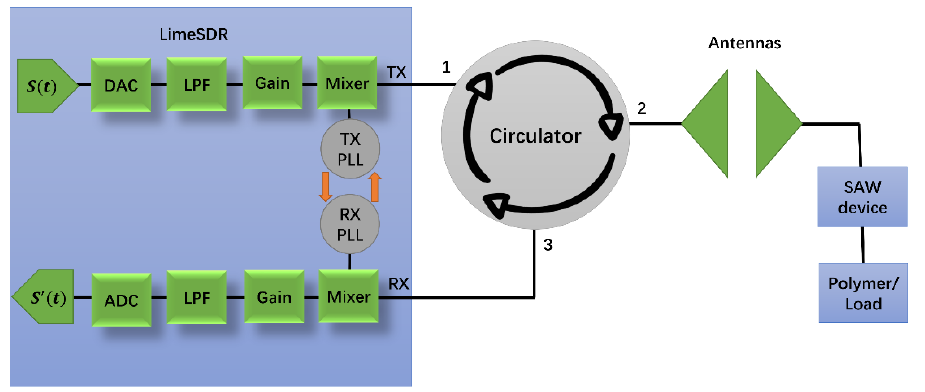
Figure 1. Proposed wireless sensing system including the LimeSDR-mini, circulator, two antennas, SAW device, and polymer (variable resistive load). On the circulator, the numbers 1, 2, and 3 mean port 1, port 2, and port 3, respectively. The circulator only allows microwave path from port 1 to port 2, port 2 to port 3, and port 3 to port 1.